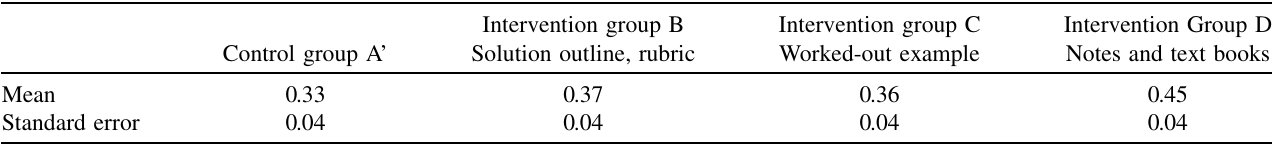
TABLE VII. Average physics grades (normalized to 1) for pre solutions for the different